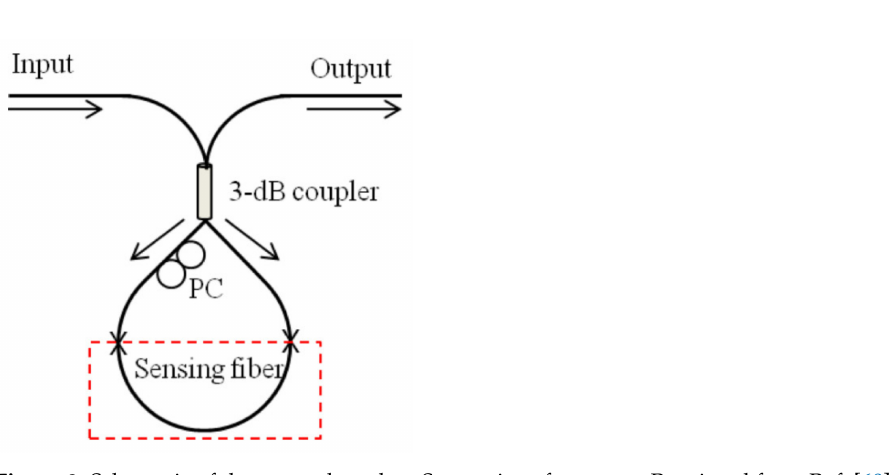
Figure 8. Schematic of the sensor based on Sagnac interferometer. Reprinted from Ref. [60]. The other type of FOI sensors is based on optical fiber gratings which use the periodic pattern in the fiber core to realize phase matching conditions by coupling the core and cladding modes. The most famous type of optical fiber gratings are long period fiber gratings (LPFGs) and fiber Bragg gratings (FBGs) [12,75,76]. The 2-D schematics of possible LPFG and FBG configurations and their transmission spectra in response to change in the outside refractive index are shown in Figure 9. A very sensitive biosensor has been reported by coating a layer of graphene oxide (GO) on an LPFG. The selective capture mechanism of streptavidin (SA) and biotin was utilized for the sensing of bovine serum albumin (BSA) with the LOD as low as 0.2 aM [77].